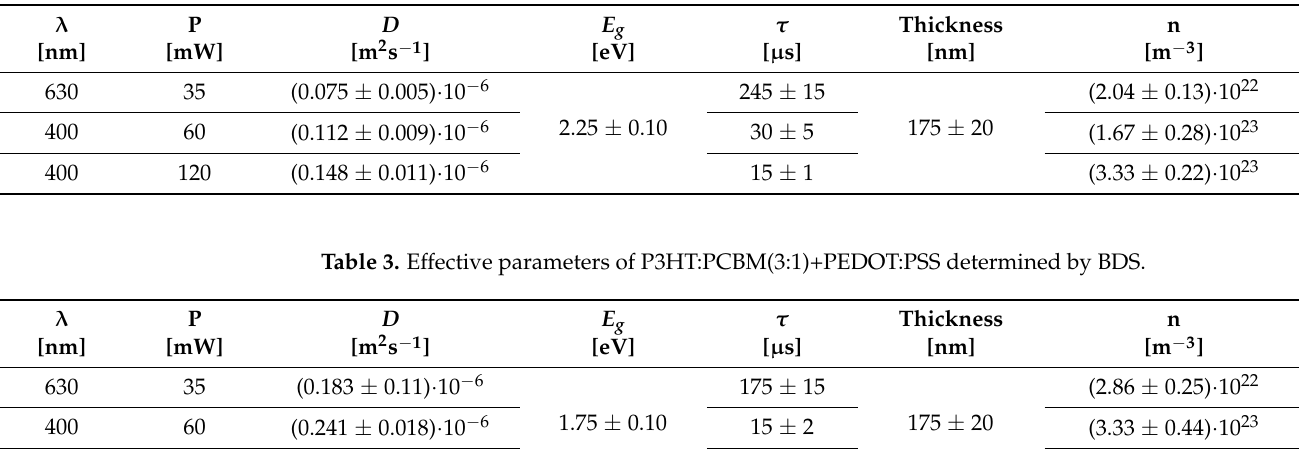
Table 2. Effective parameters of P3HT:PCBM(1:3)+PEDOT:PSS determined by BDS.